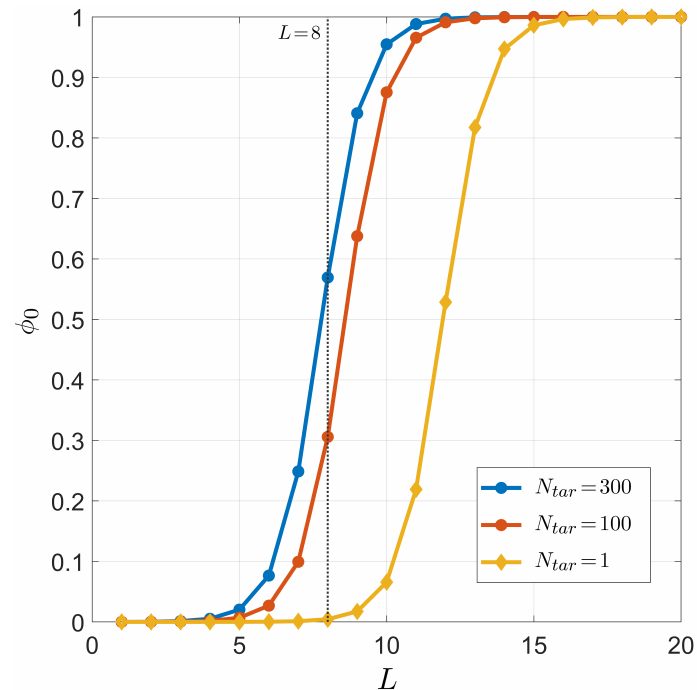
Figure 7. Dependence on the miRNA length L of the target pairing probability φ 0 for fixed temper- ature T = 37 ◦ C, total sites L 0 = 1.1 × 10 7 , salt concentration [ Na + ] = 150 mM, and CG fraction n CG = L /2. Curves correspond to different numbers of distinct miRNA targets N tar . Yellow dots: N tar = 1. Red dots: N tar = 100. Blue dots: N tar = 300. The gray line marks L = 8, the typical length of the seed region of